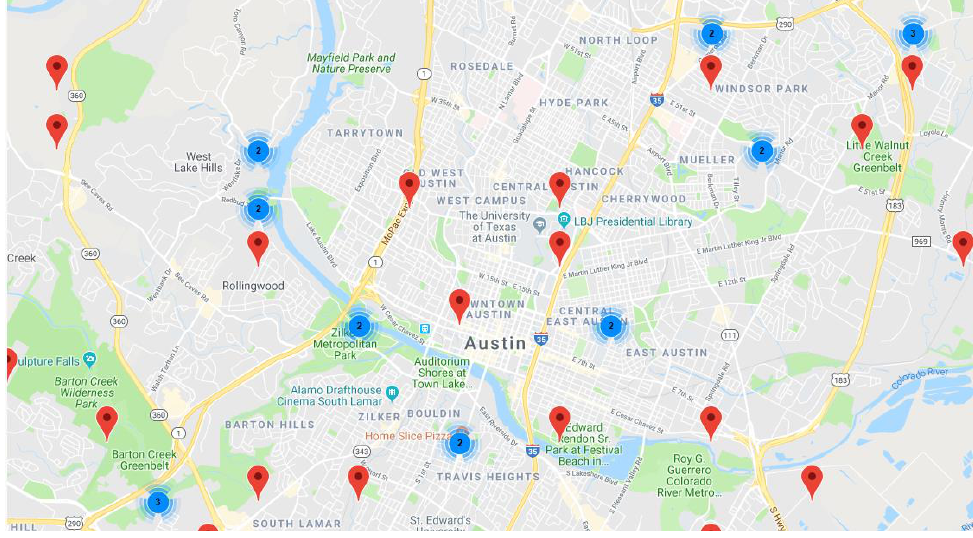
Figure 12. Map of simulated households’ locations.